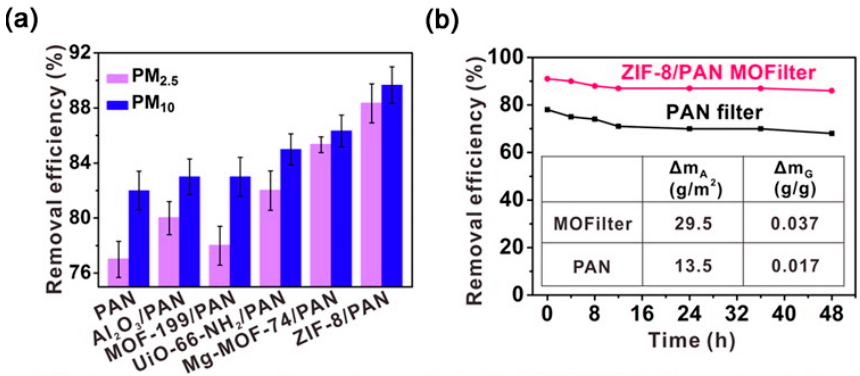
Figure 11. ( a ) Particulate matter removal efficiencies of polyacrylonitrile (PAN) filter, Al 2 O 3 @PAN filter and MOF@PAN filter ( b ) Long term PM 2.5 removal efficiencies of PAN filter and ZIF-8@PAN filter. Reproduced and adapted from Ref. [58]; Copyright (2016), ACS Journal of American Society.